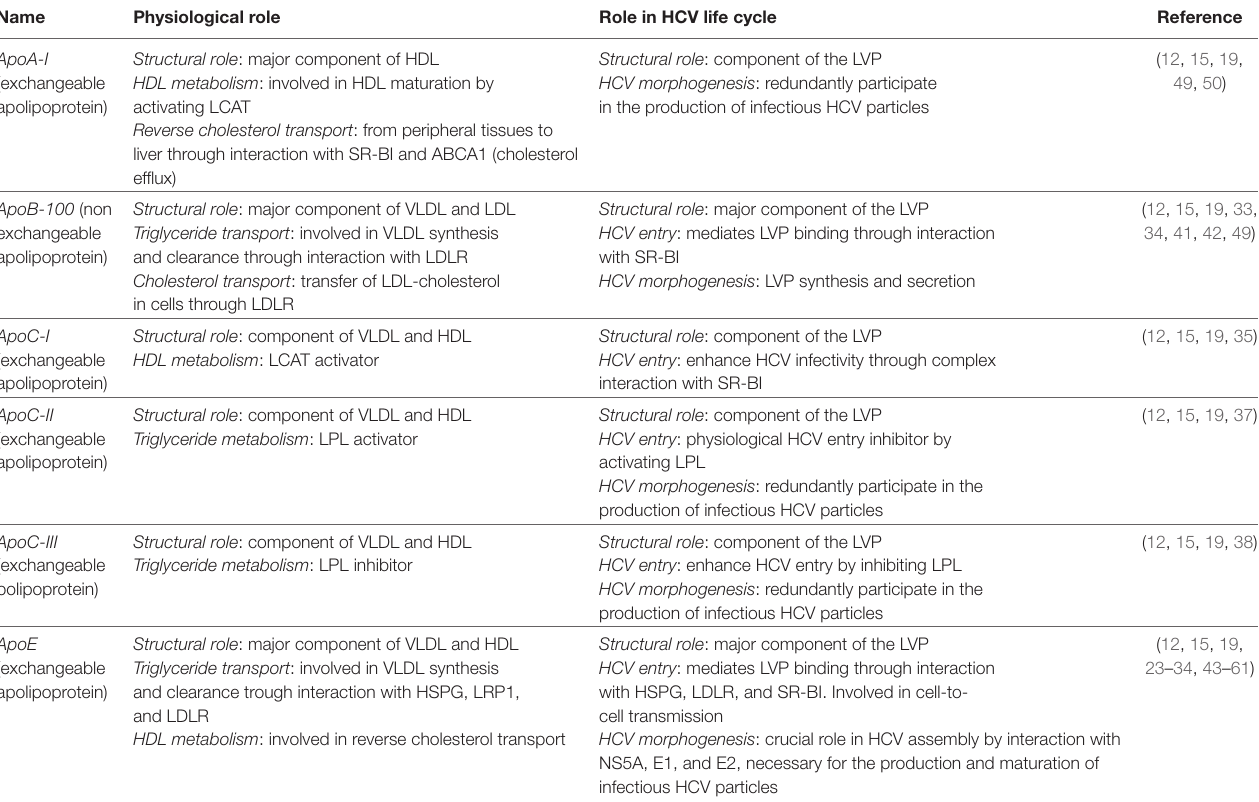
TAbLe 1 | Role of the major apolipoproteins in the HCV life cycle.